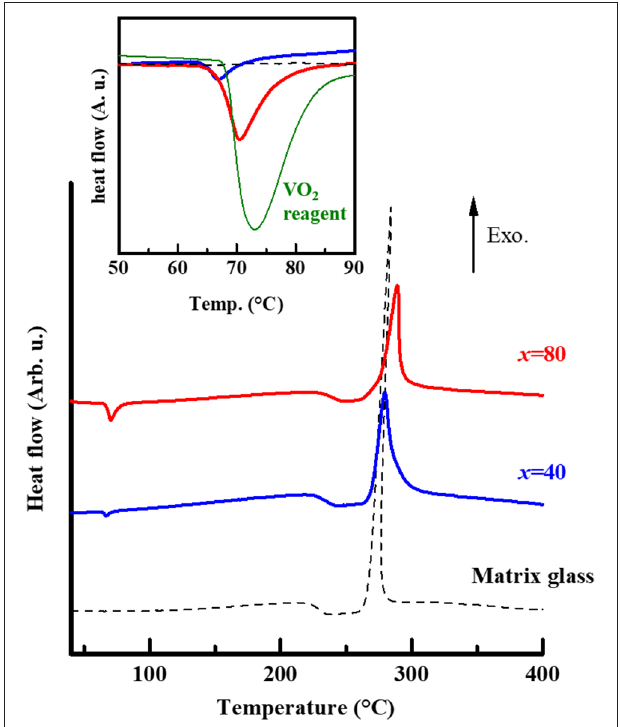
FIGURE 2 | Differential thermal analysis (DTA) results of the dispersed samples, 15B 2 O 3 -10P 2 O 5 -75V 2 O 5 : x ( x = 40 and 80; the studied samples are bulk form), together with the result of matrix glass referred from the paper (Muramoto et al., 2018). The inset shows the DTA curves in a low-temperature region, in which an endothermic reaction was observed in the heating process. The endothermic peaks with onset temperature are around the vicinity of T c ∼ 68 ◦ C, indicating the structural phase transition of the dispersed VO 2 phase. The DTA result in the VO 2 reagent used in this study is also included (green curve; peak intensity was reduced to fit the graph).